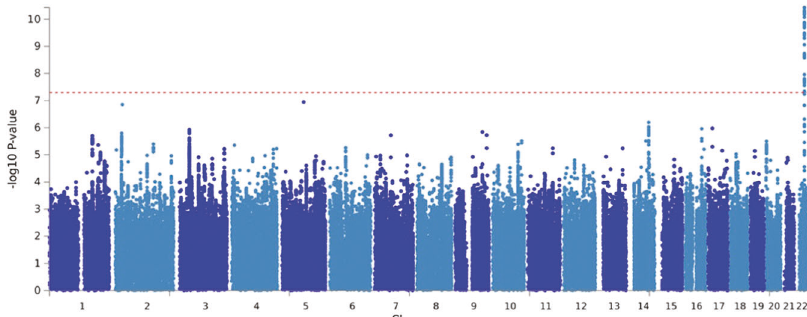
Fig. 1 Manhattan plot of the MGUS association. Y -axis shows genome-wide P-values (two-sided, calculated using SNPTEST v2.5.2 assuming an additive model) of >6 million successfully imputed autosomal SNPs. The x-axis shows the chromosome number. The red horizontal line represents the genome-wide signi fi cance threshold of P = 5.0 × 10 − 8